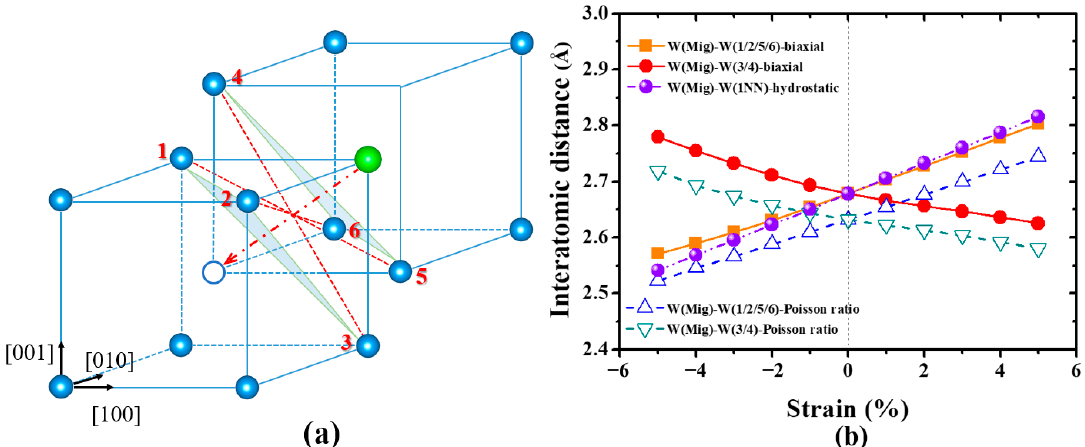
Figure 6. ( a ) The atomic structure during the migration of a monovacancy in W. The green sphere and white circle represent the Mig-W atom and vacant site, respectively. ( b ) The interatomic distances between the Mig-W and its NN atoms for the transition state. The dash dot/solid line corresponds to hydrostatic/biaxial strain, respectively. The dashed line is deduced according to the Poisson ratio.